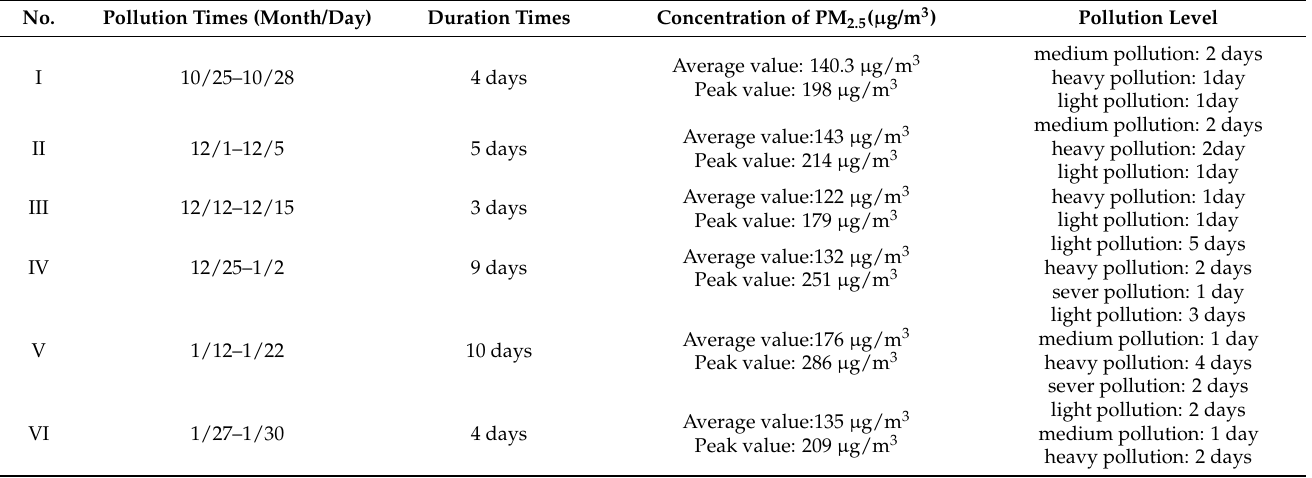
Table 5. Information of pollution processes at the autumn-winter season of